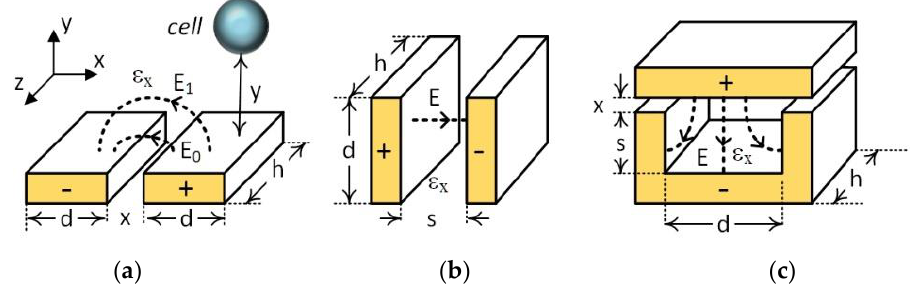
Figure 1. Three Capacitive sensor structures and the electric field distributions in; ( a ) 1D coplanar interdigital capacitor (IDC), ( b ) 2D parallel plate capacitor (PPC), ( c ) 3D PPC.